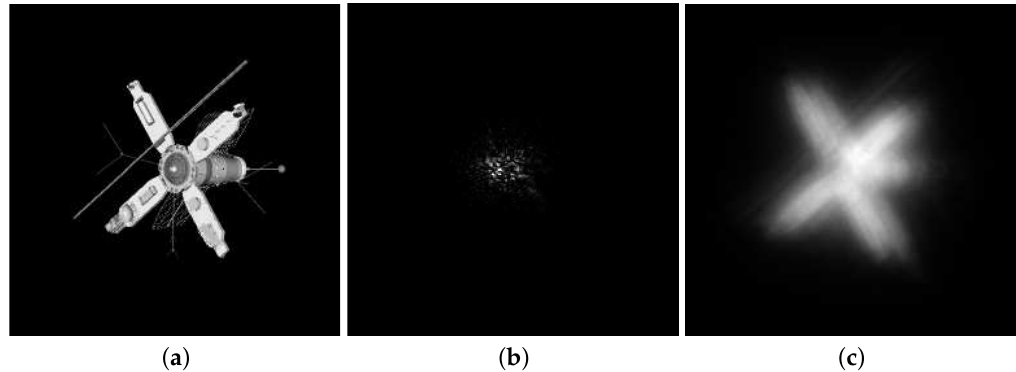
Figure 7. Satellite test problem: ( a ) True image (256 × 256 pixels), ( b ) PSF (256 × 256 pixels), ( c ) Blurred and noisy image with ≈ 1% of white Gaussian noise (256 × 256 pixels).